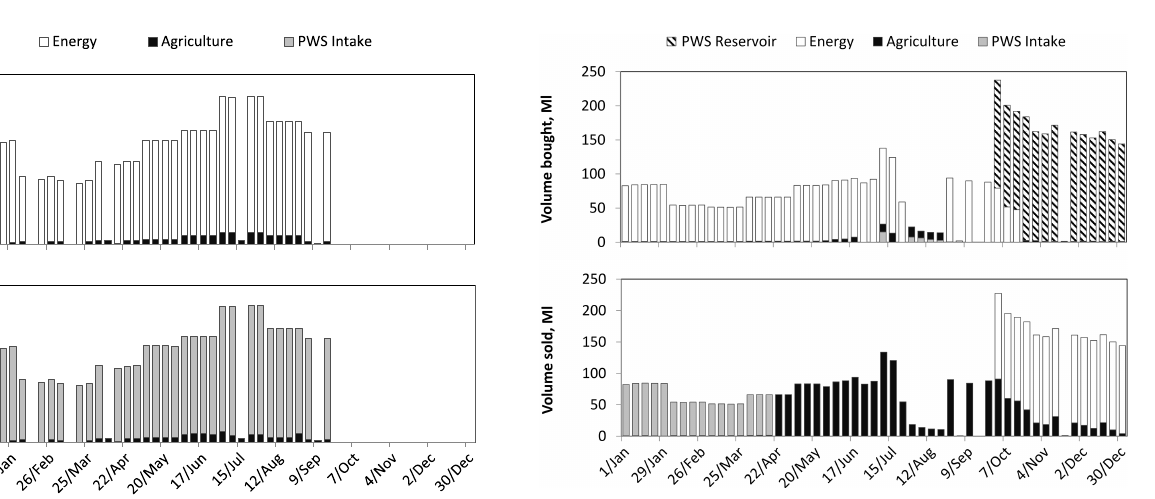
Figure 5. Water volumes bought (top panel) and sold (bottom panel) in millions of litres (ML) per week by sector under the current li- censing (volumetric) system.